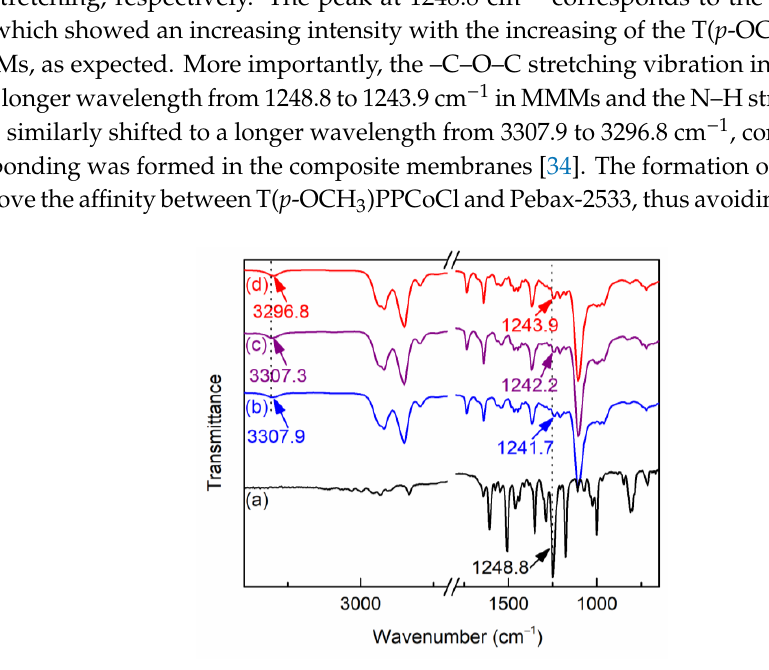
6 of 14 Figure 1. UV-vis spectra of T( p -OCH 3 )PP and T( p -OCH 3 )PPCoCl.